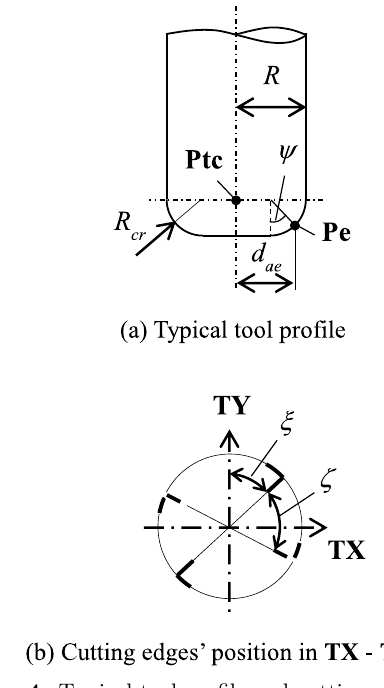
Fig. 4. Typical tool pro fi le and cutting edges ’